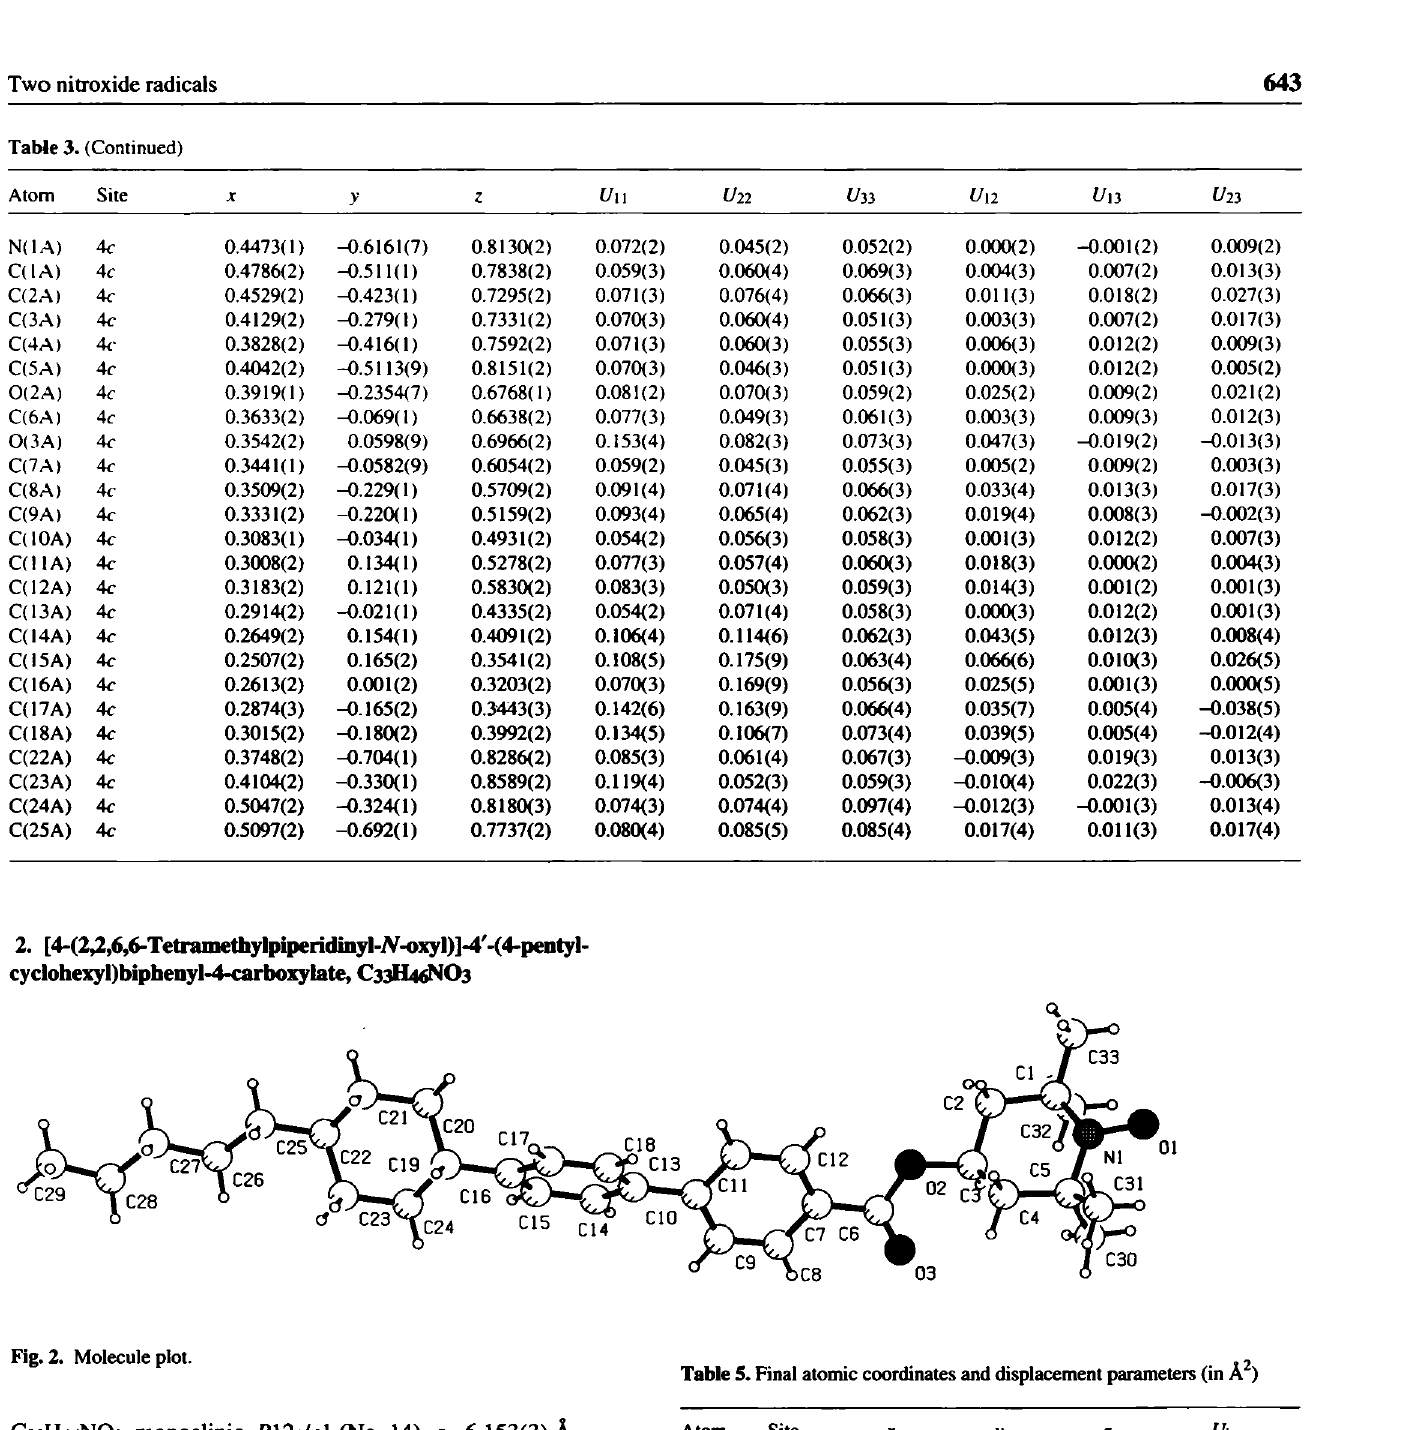
Table 5. Final atomic coordinates and displacement parameters (in